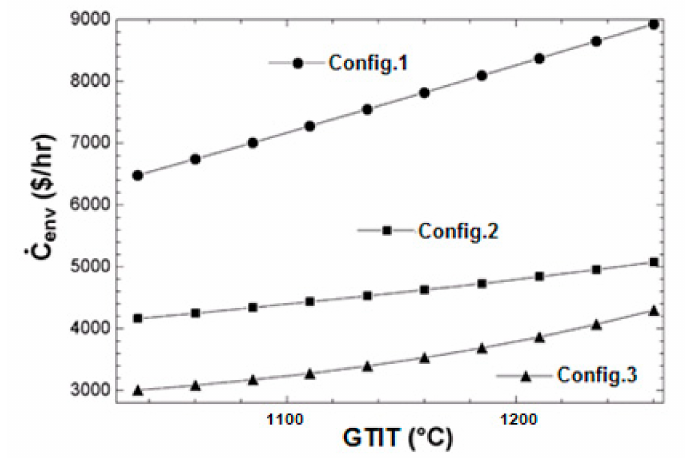
Figure 12. Effect of gas turbine inlet temperature change on the environmental cost rate.